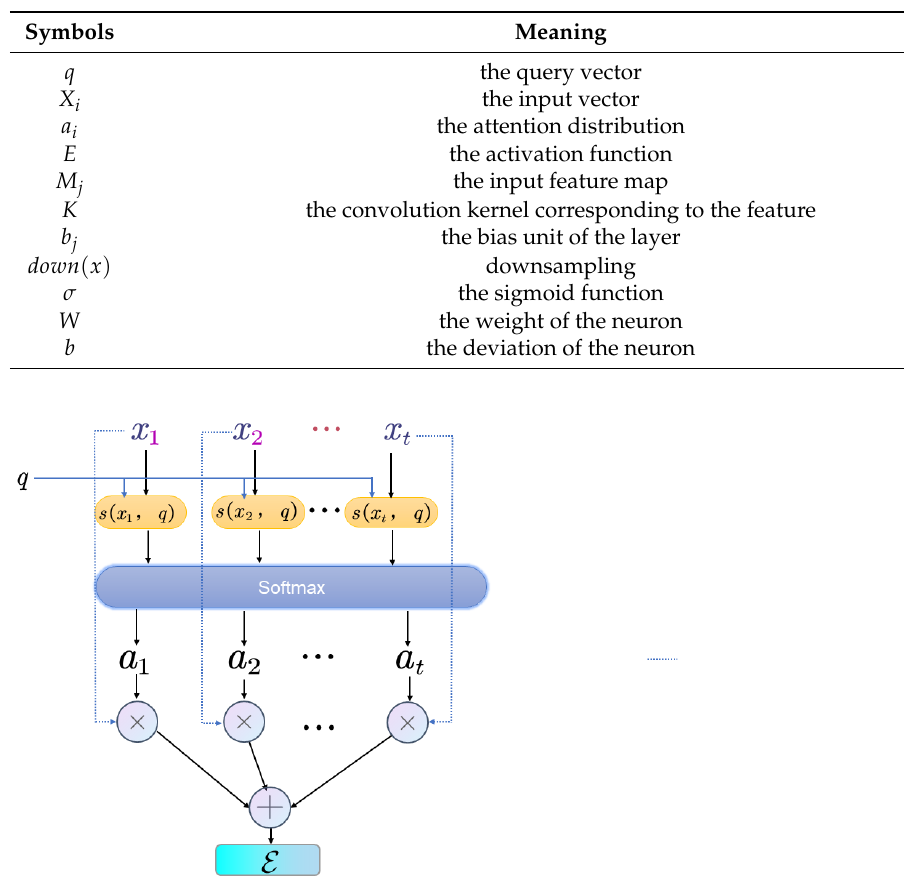
Table 1. Summary table of the symbols used in the text.